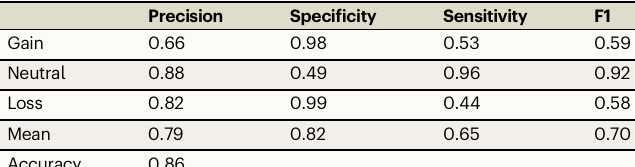
Table 1 | The performance and accuracy of CNA prediction in mCRPC samples from the VPC cohort Precision Speci fi city Sensitivity